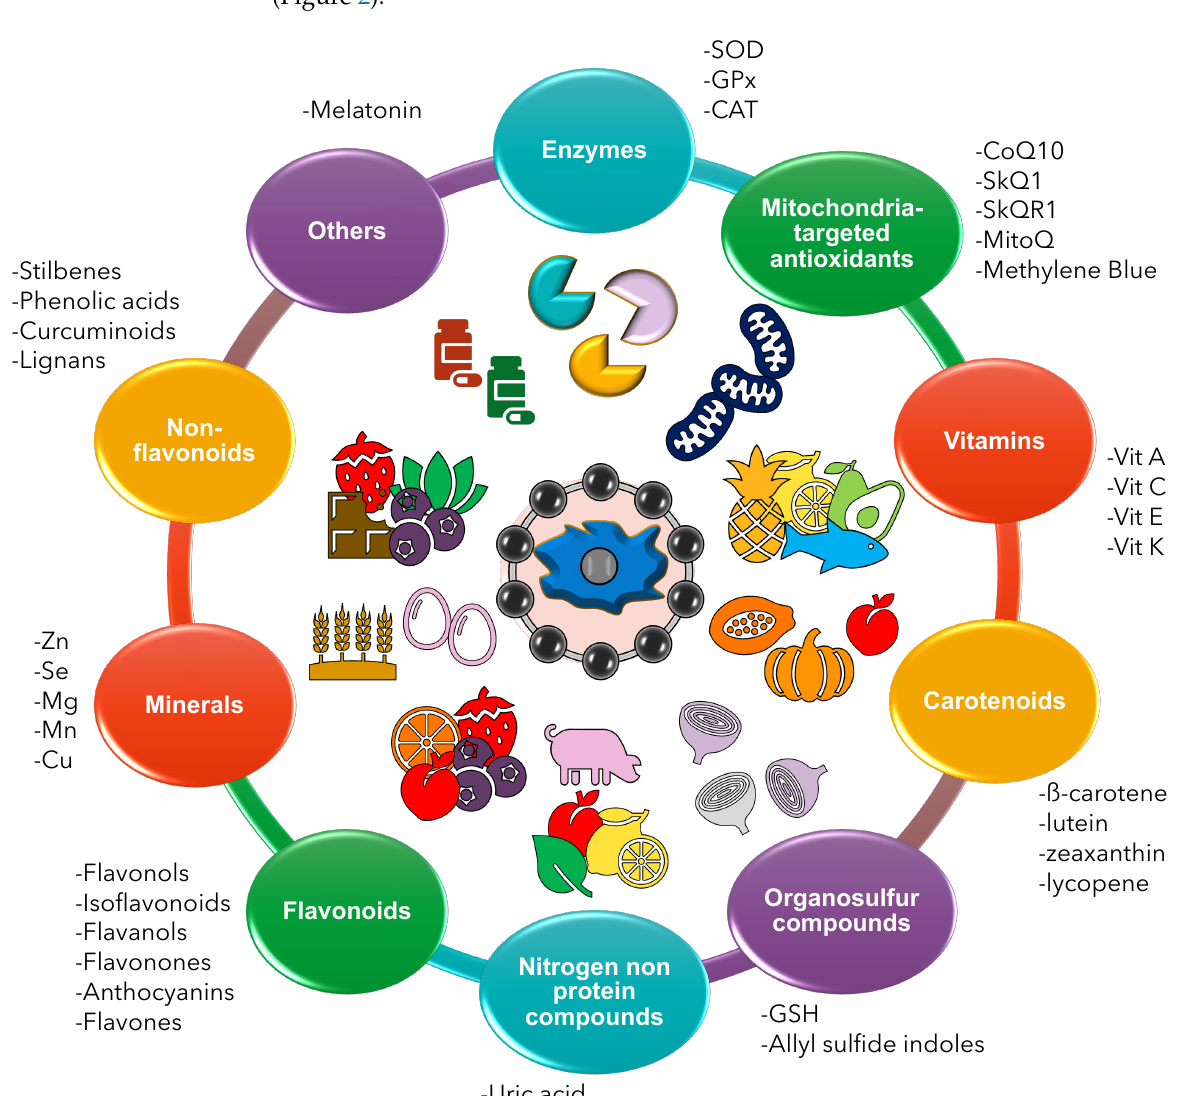
Figure 2. Antioxidants: classification. The figure illustrates the main classes of antioxidants capable of counteracting oxidative stress-induced senescence: enzymes, mitochondria-targeted antioxidants, vitamins, carotenoids, organosulfur compounds, nitrogen non protein compounds, flavonoids, min- erals, non-flavonoids, and